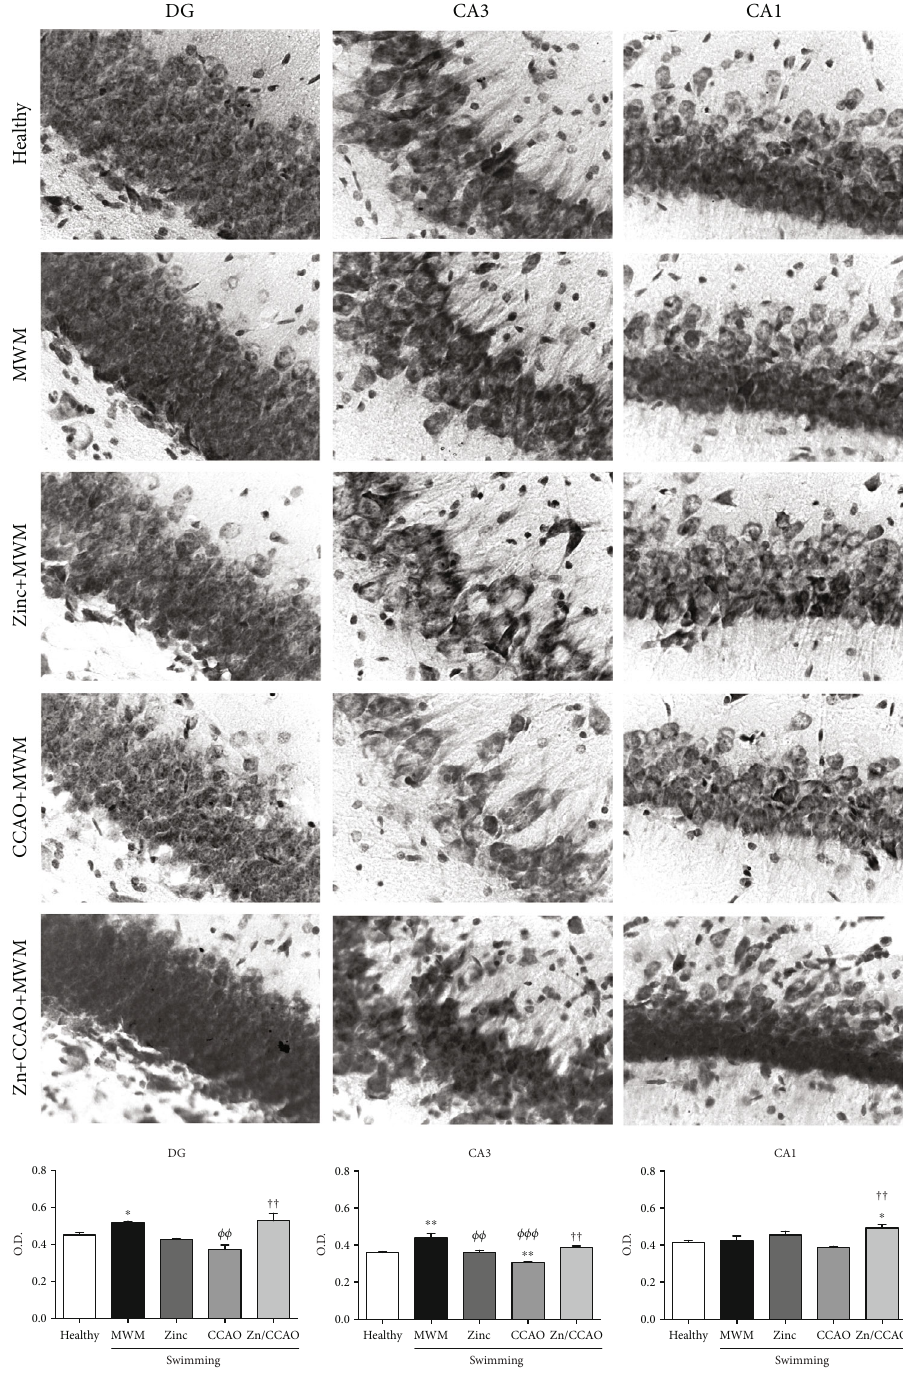
Figure 7: The subacute prophylactic zinc administration and swimming (Morris Water Maze, MWM) prevented tissue damage induced by 30min CCAO in the hippocampus, as revealed by Nissl staining. O.D.: optical density. The values are mean ± SEM ( n = 4 ) and analyzed with one-way ANOVA and Dunnett ’ s post hoc multiple comparisons. P < 0 : 05 , ∗ compared with the healthy group, Φ compared with the MWM group, and † compared with the CCAO